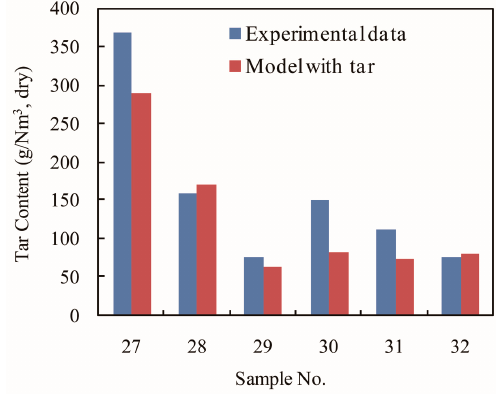
Figure 4. Comparison between experimental data and predicted date for tar content.